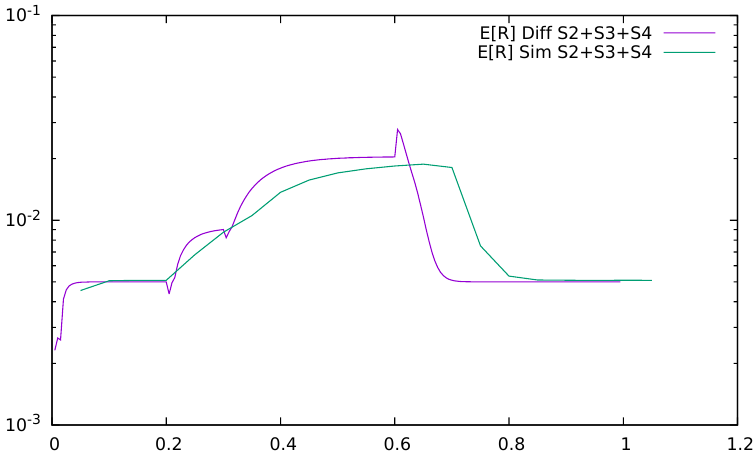
Figure 28. Mean delay introduced by the communication with the controller as a function of time, (cid:101) = 0.5, diffusion, and simulation results.